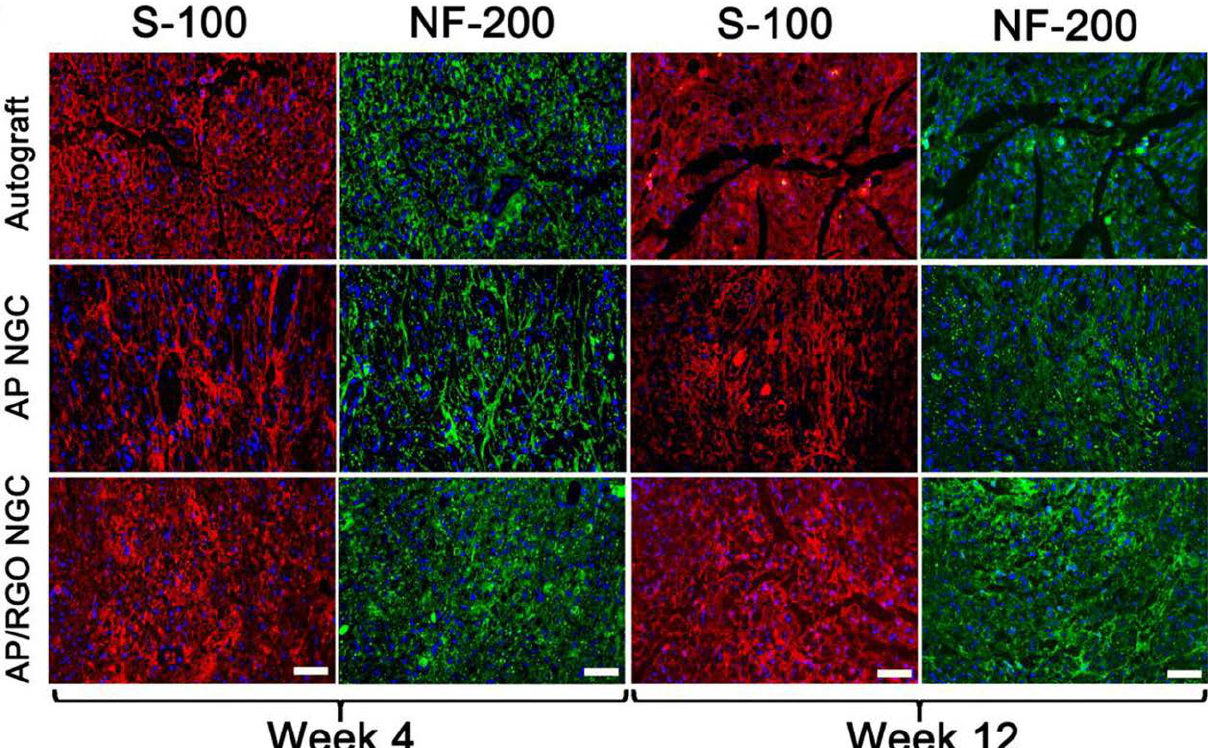
Figure 11. Images of immunofluorescence staining of S-100 and NF-200 in the regenerated nerve tissues (autograft, unmodified scaffold, scaffold modified by rGO). Scale bar equals 50 μm. Reprinted from [101 ] with permission from Elsevier.